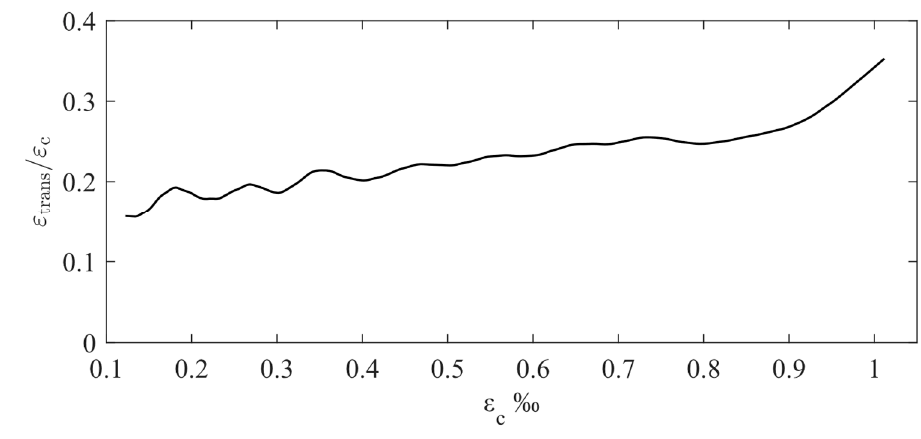
Figure 9. Dependences between average ε trans / ε c and ε c